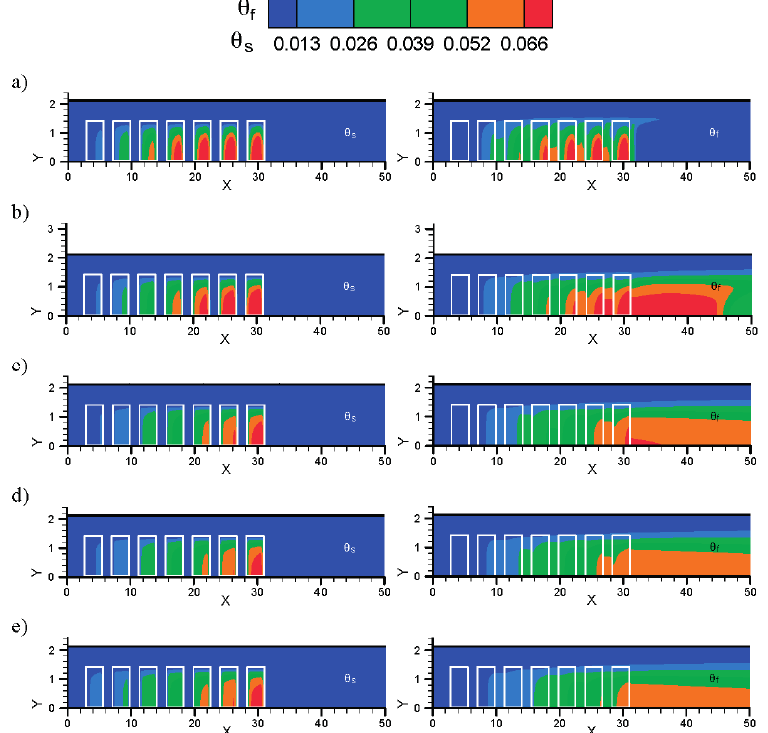
Figure 12. Dimensionless temperature contours for various test samples with X T * = X L * = 1.5 (the scales of X -axis and Y -axis are different): ( a ) Sample 1; ( b ) Sample 2; ( c ) Sample 3; ( d ) Sample 4; and ( e ) Sample